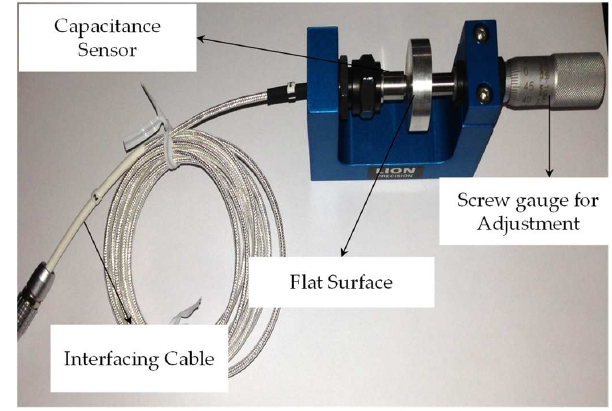
Figure 5. Hardware setup for sensor calibration .